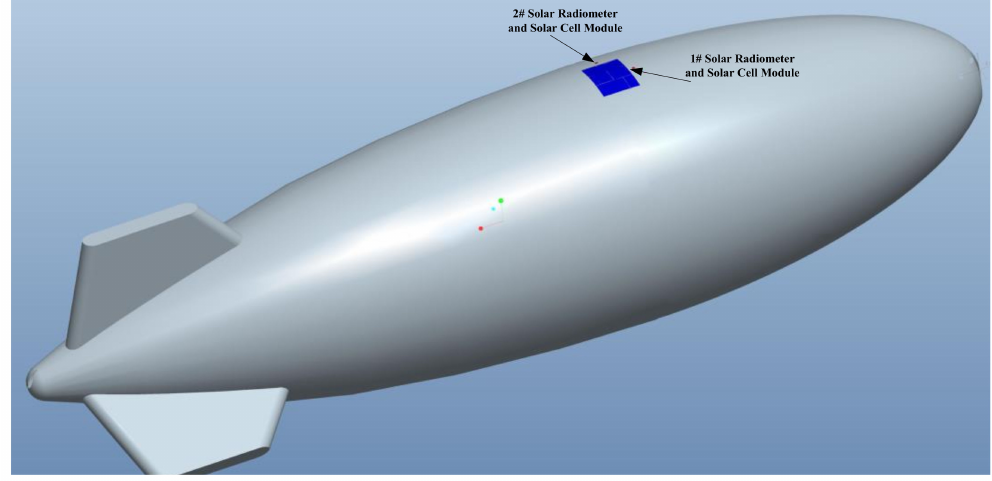
Figure 4. Diagram of solar cell modules